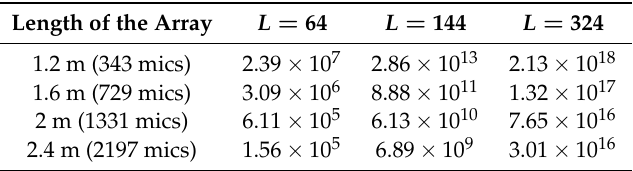
Table 1. Condition number of the matrix H ( ω ) as a function of the size of the microphone array and the number of plane